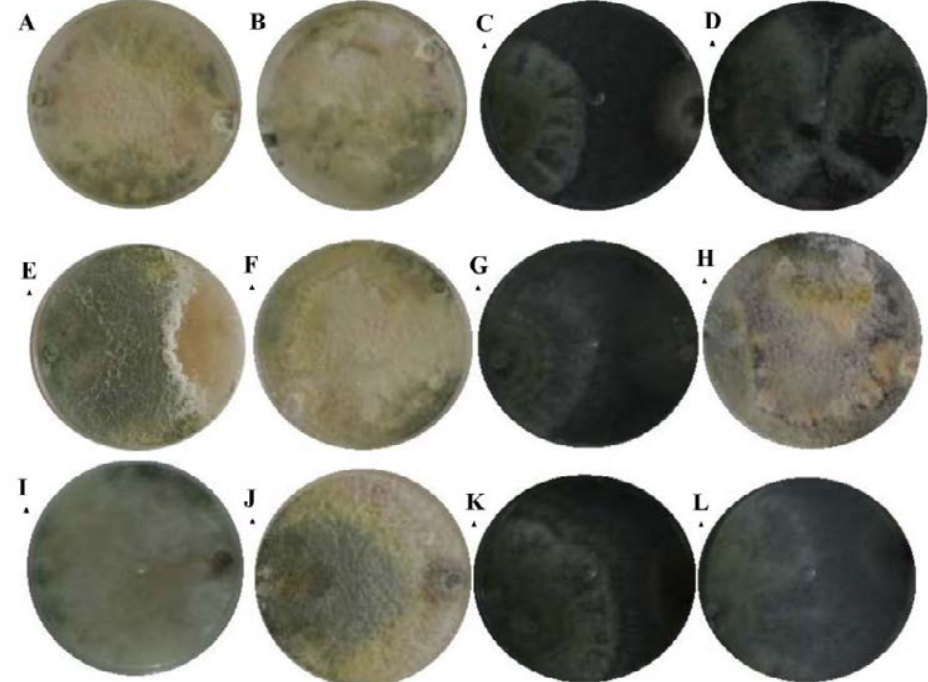
Fig. 4. Bell 15 scale at 7 days of observation; T. hamatum presented a type II antagonism against Colletotrichum sp. (A), type I in Fusarium sp. (E) and Pythium sp. (I); T. harzianum , presented a type I antagonism against Colletotrichum (B), Fusarium sp. (F) and Pythium sp. (J); T. viride , I present a type II antagonism against Colletotrichum sp. (C), Fusarium sp. (G) and Pythium sp. (K) and T. atroviride , I present a type III antagonism against Colletotrichum sp. (D), type I for Fusarium sp. (H) and Pythium sp.